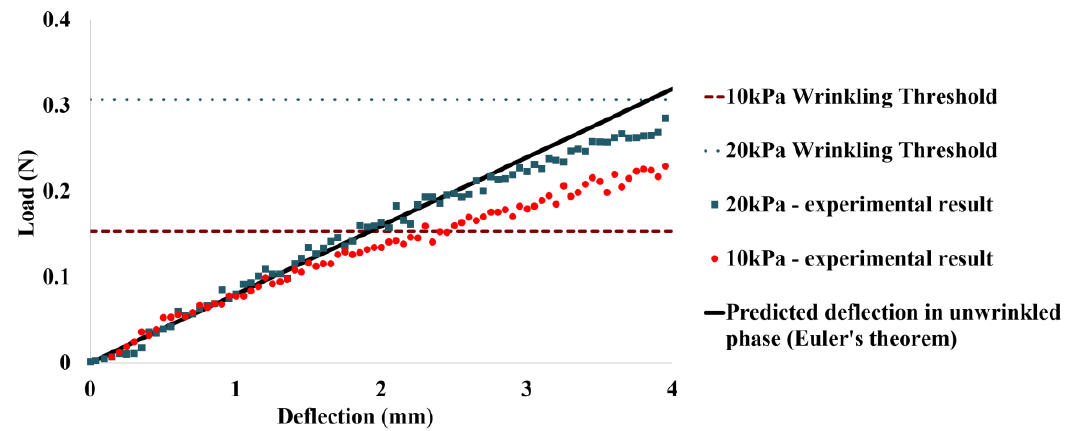
Figure 5. Load–deflection behavior of the IB module.